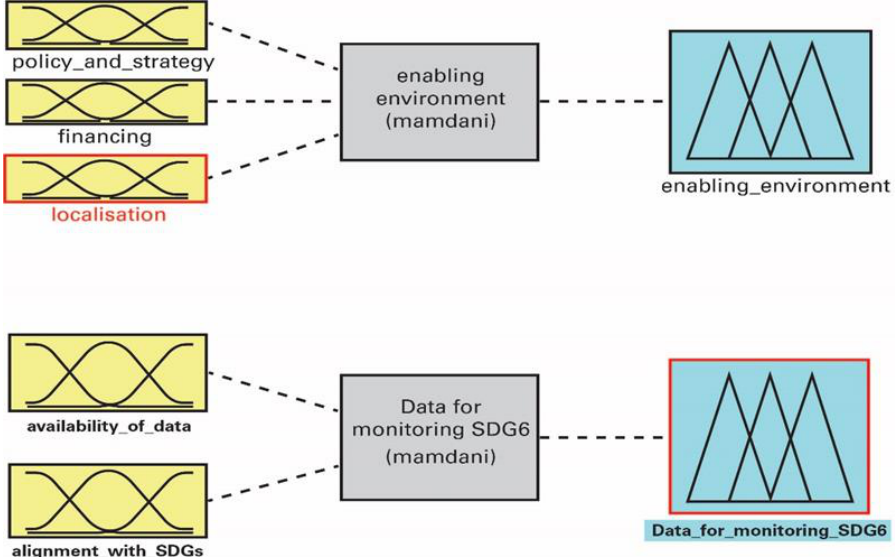
Figure 6. Input variables for fuzzy logic analysis of enabling environment and data for monitoring SDG 6. Table 2. Rule set for enabling environment factor for fuzzy